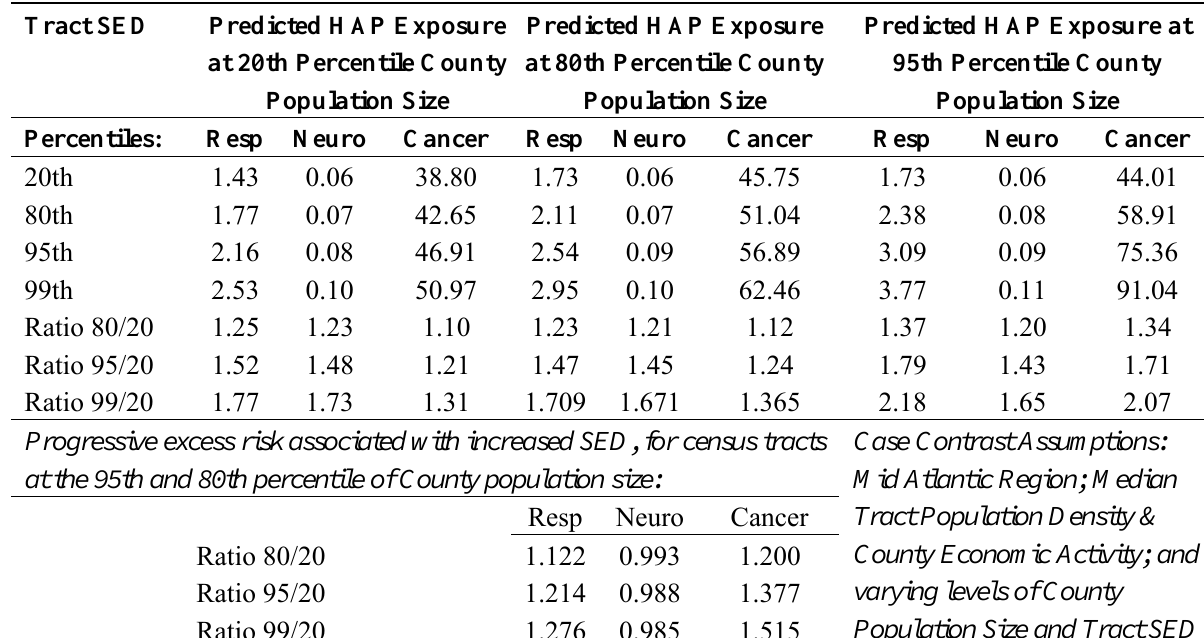
Table 4. Profile of SED Effect Modification of HAP Exposure Risk after Adjustment for County Population Size and Economic Activity and Tract Population Density: Respiratory, Neurological, and Cancer Exposure Hazards, 2005. Tract SED Predicted HAP Exposure Predicted HAP Exposure Predicted HAP Exposure